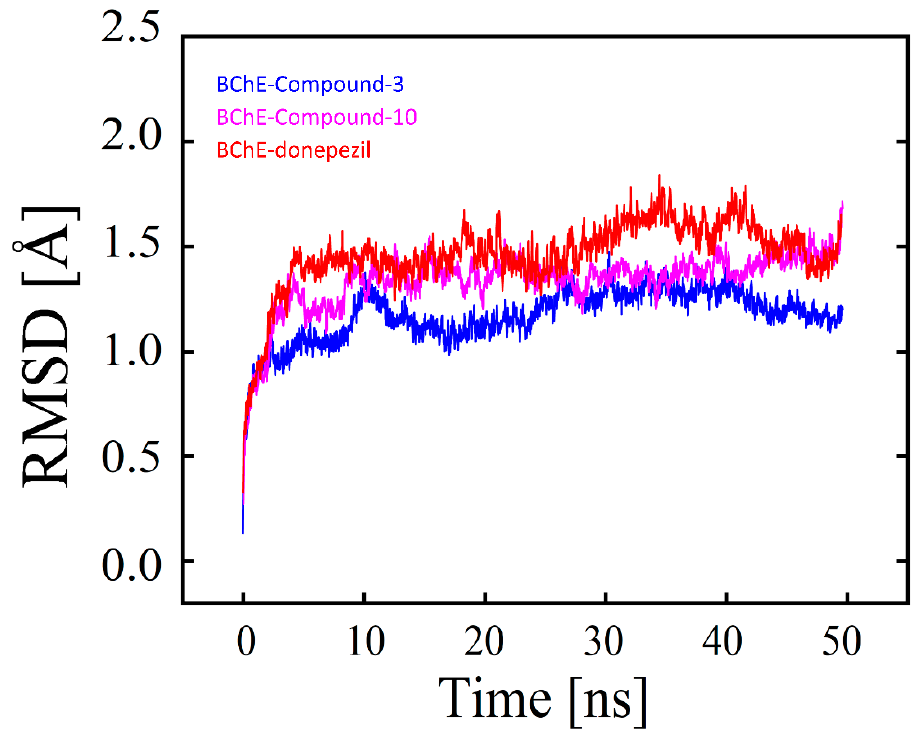
Figure 4. RMSD plot of compound 3 (blue color), compound 10 (magenta color), and donepezil (red color) in complex with BuChE.